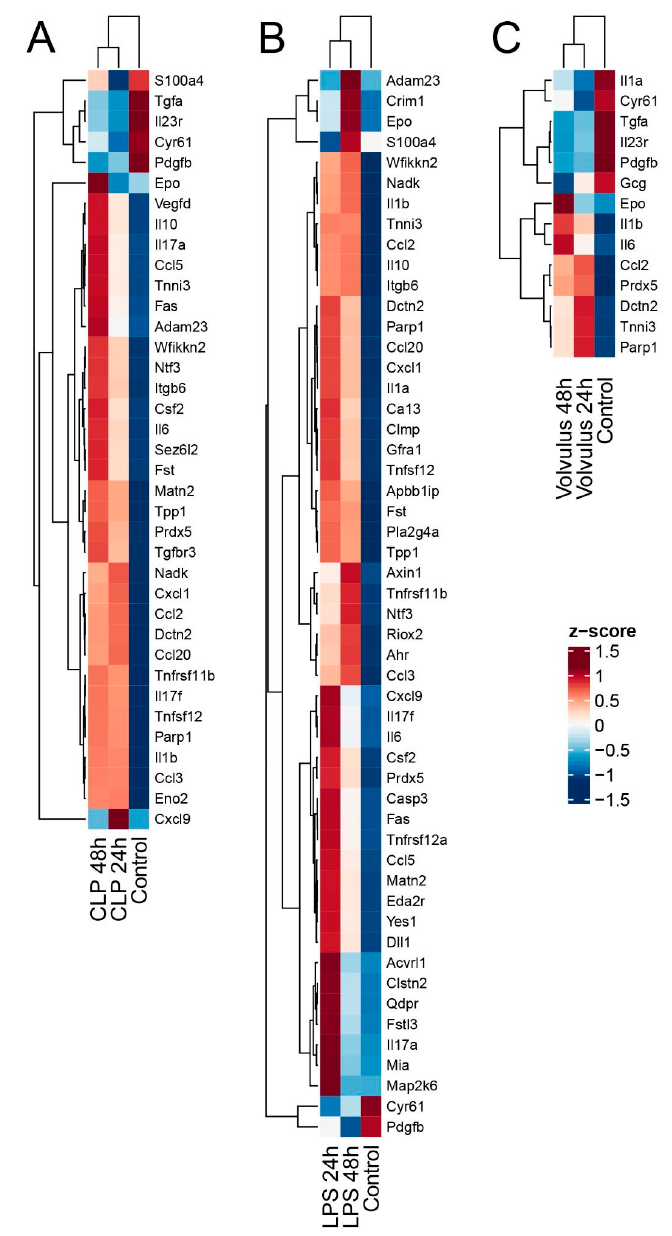
Figure 6. Several plasma proteins are differentially expressed in the three models of septic condi- tions at 48 h and 24 h in comparison to healthy controls. 48 h and 24 h levels of plasma proteins ( A ) CLP, ( B ) LPS, and ( C ) midgut volvulus are shown together with corresponding controls as heat maps. Z-scores are displayed.